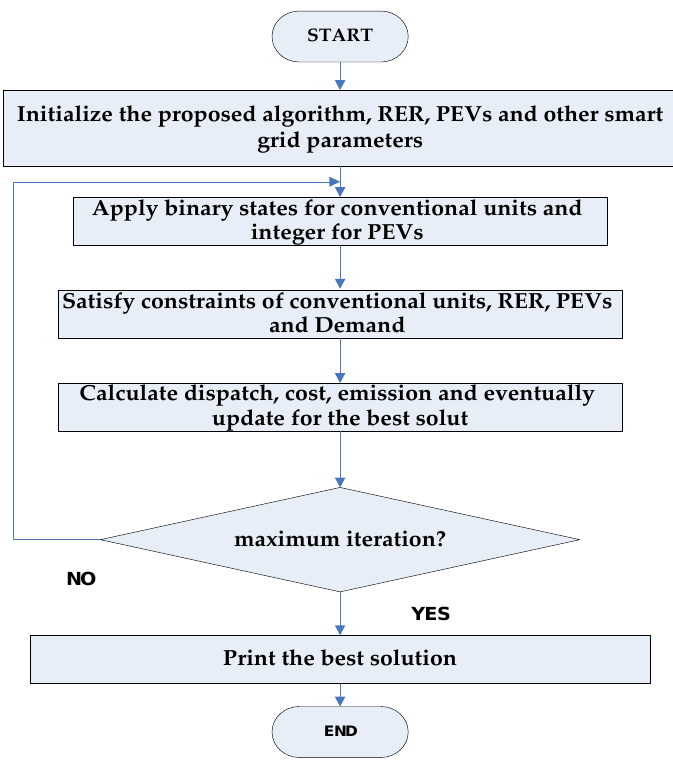
Figure 1. The flowchart for minimizing both emission and cost by utilizing plug-in electric vehicles (PEVs) and renewable energy resources (RERs).